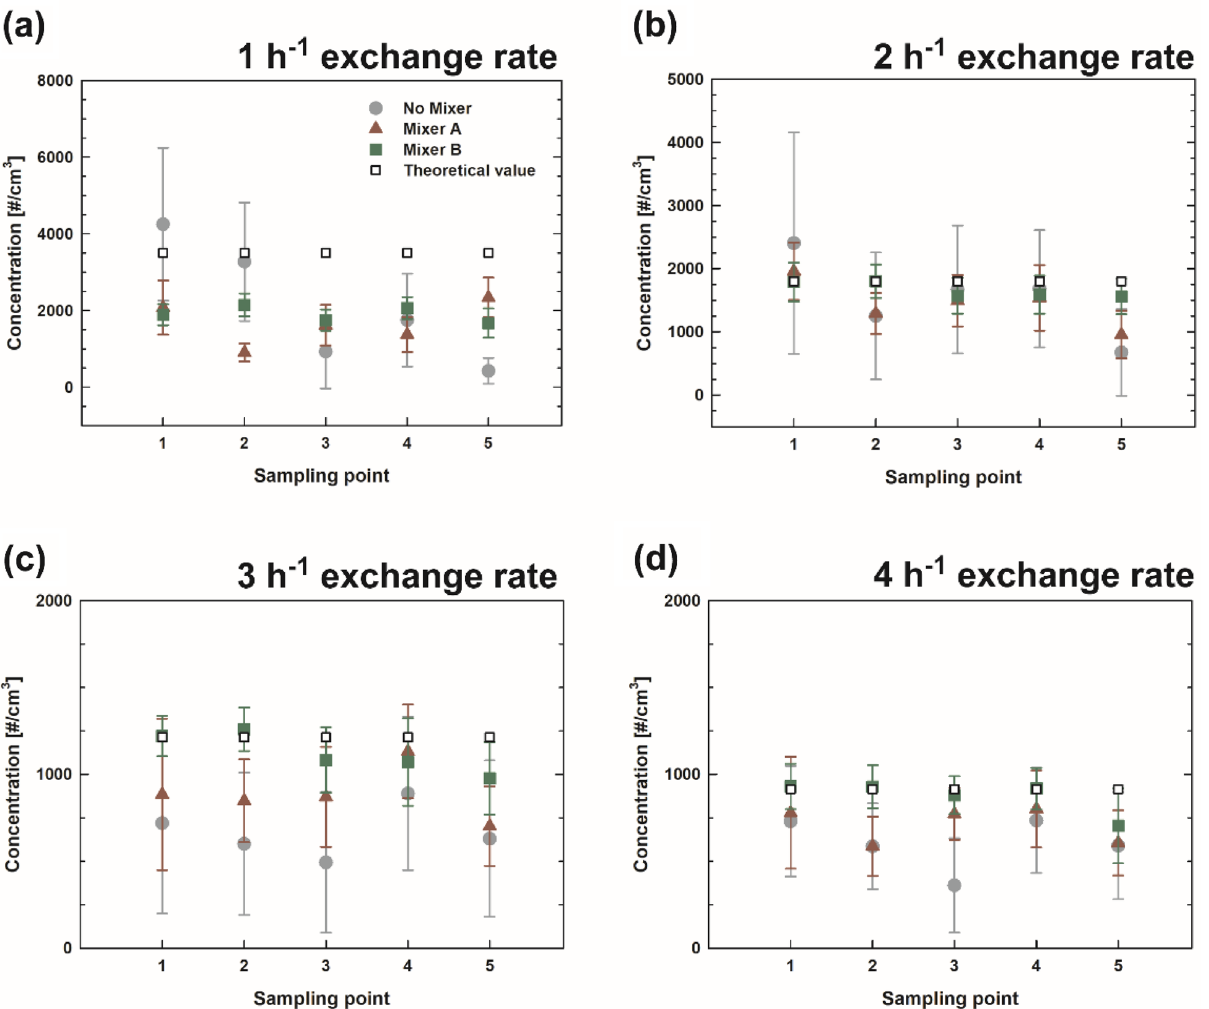
Figure 5. Concentration measured at different sampling points with and without a mixer for the exchange rate of ( a ) 1 h −1 , ( b ) 2 h −1 , ( c ) 3 h −1 , and ( d ) 4 h −1 . Exchange rate [h −1 ] 1 Without mixer 0.54 ±